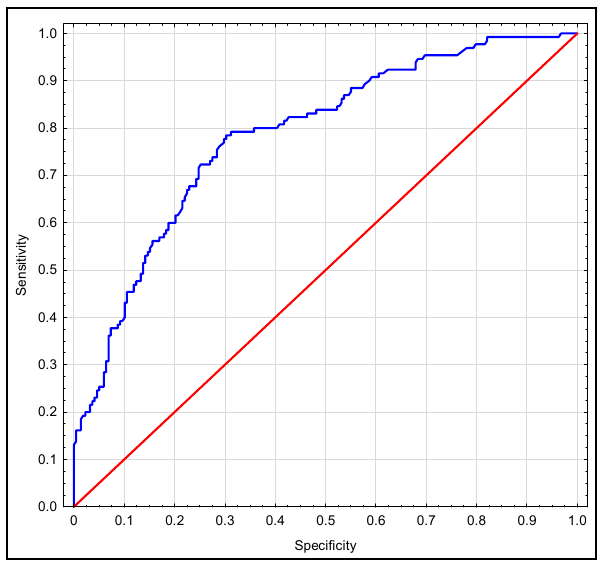
Figure 1. ROC curve for the model of the tendency to indebtedness of farms in Central Pomerania. Source: Own study.